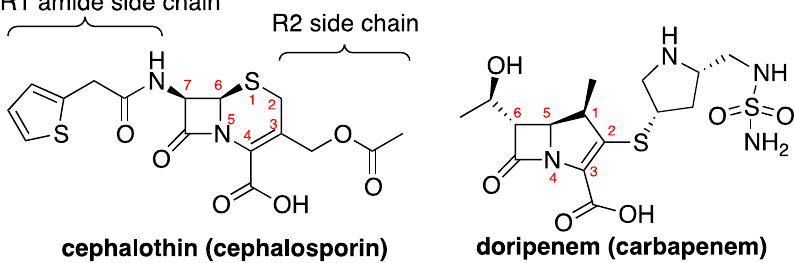
Figure 1. Structures of common cephalosporins and carbapenems (cephalothin and doripenem).